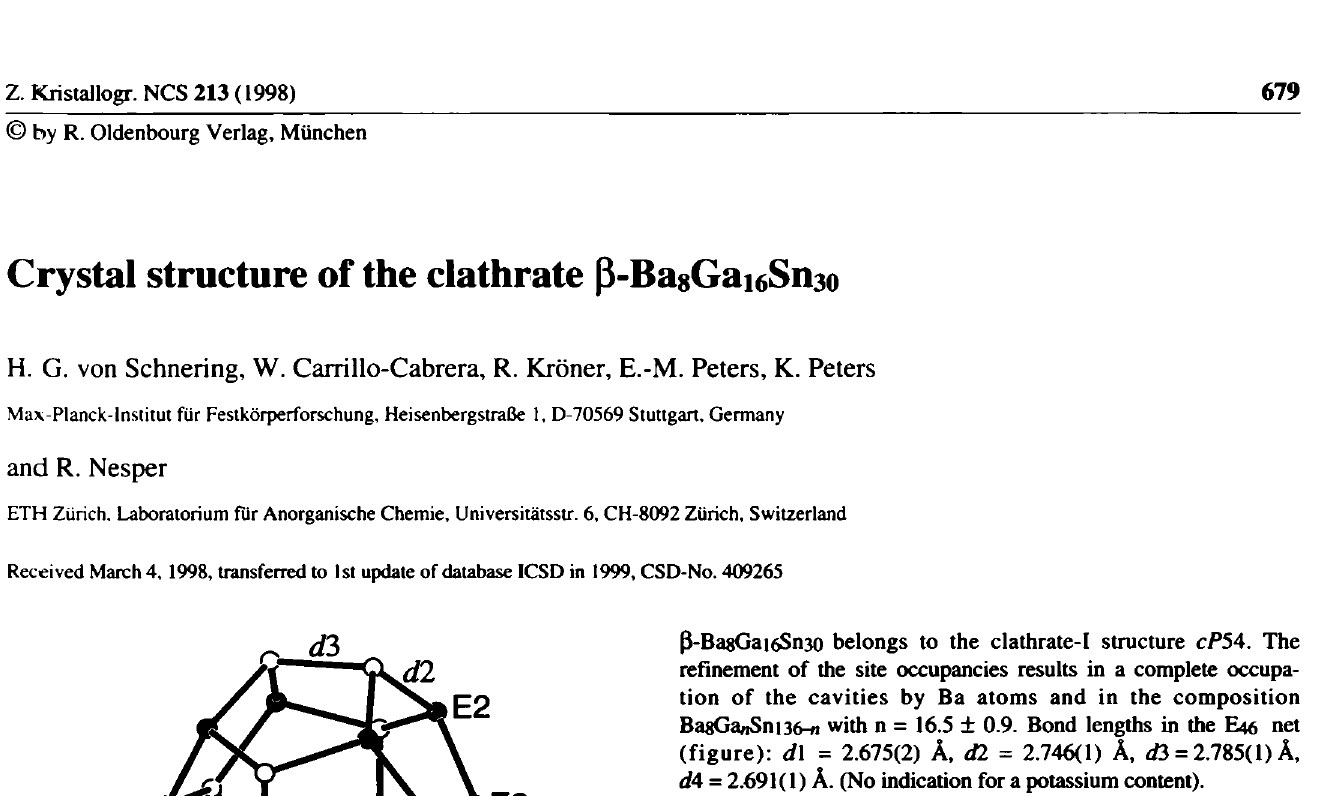
ß-BasGaiöSnao belongs to the clathrate-I structure cP5A. The refínement of the site occupancies results in a complete occupa- tion of the cavities by Ba atoms and in the composition (figure): d\ = 2.675(2) Â, d2 = 2.746(1) Â, Л = 2.785(1) Â, dA = 2.691(1) Â. (No indication for a potassium content). Obviously, BasGaieSnso exists in two modifications, namely α (c/54, see ref. 2) and β (cP5A, clathrate-I). The stability ranges of the two phase are not known, but both belong to the Zintl phases.